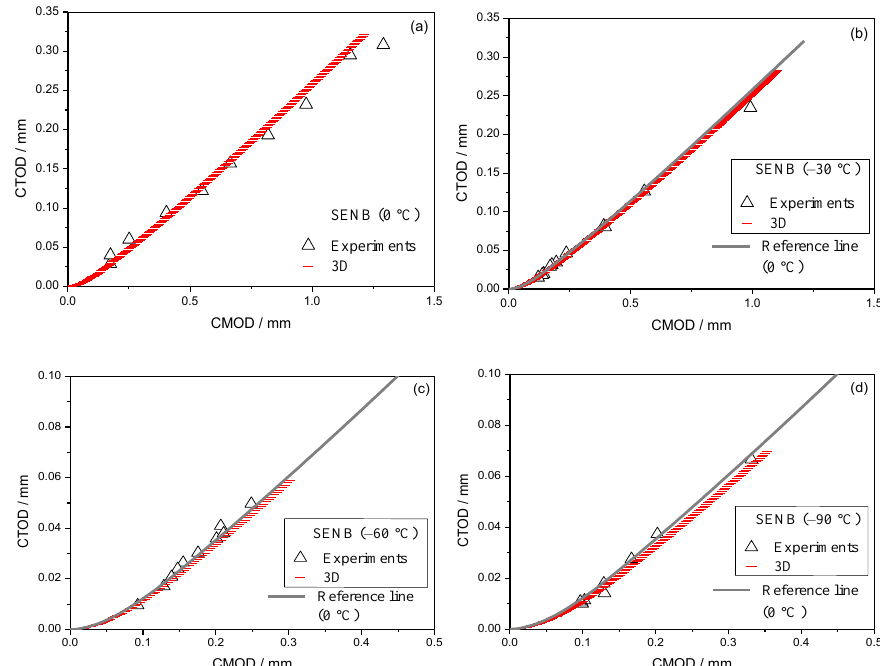
Figure 9. Q vs. CTODs for both SENB and SENT specimens, T = 0 °C, −30 °C, −60 °C, and −90 °C.